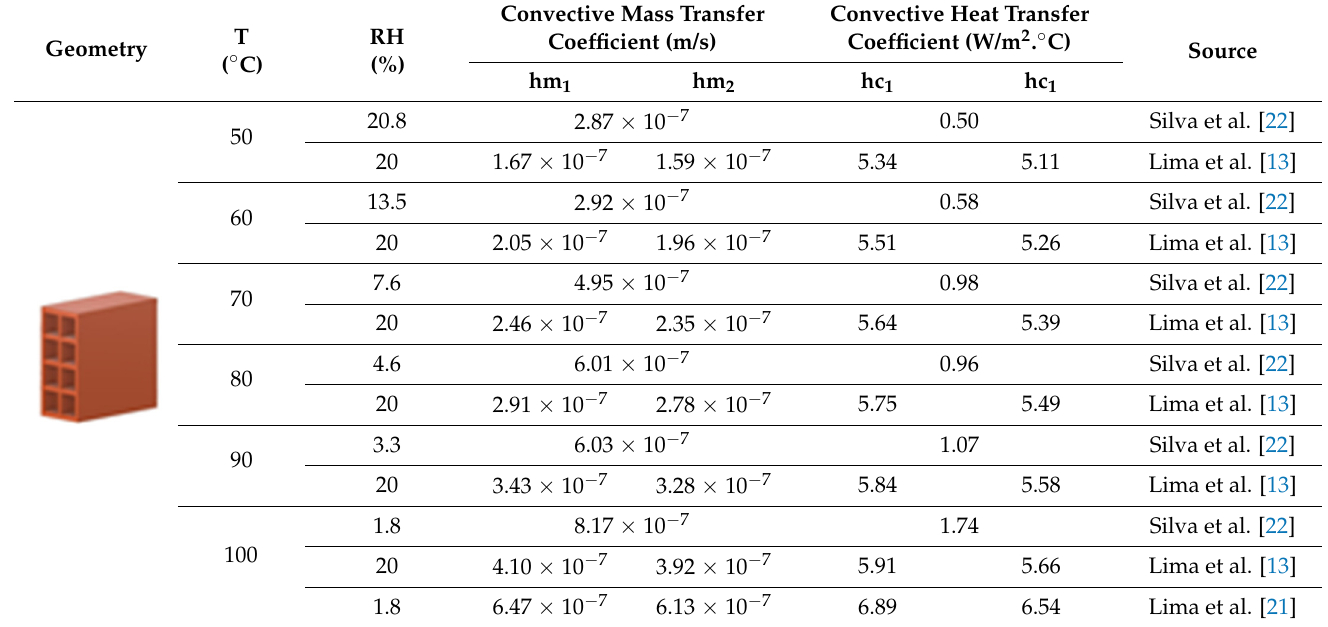
Table 7. Heat and mass transfer coefficients obtained in the drying of ceramic bricks reported in the literature.